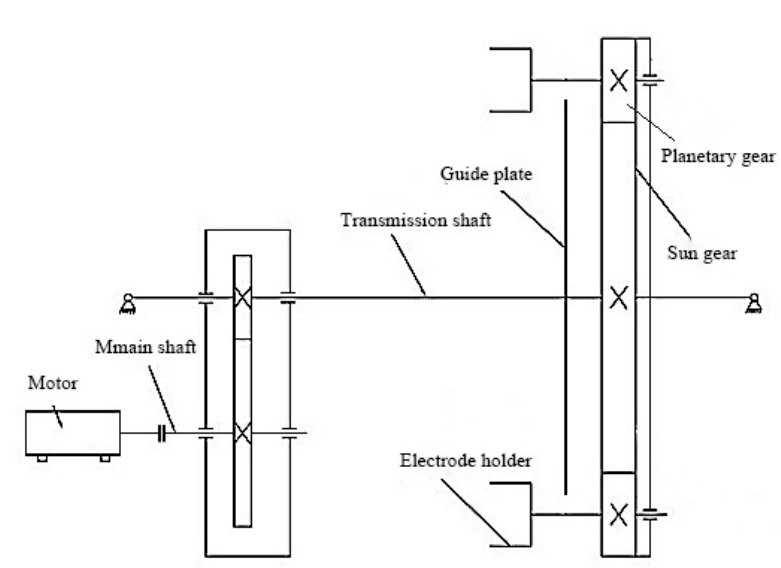
Figure 3. Transmission mechanism of the coating device.